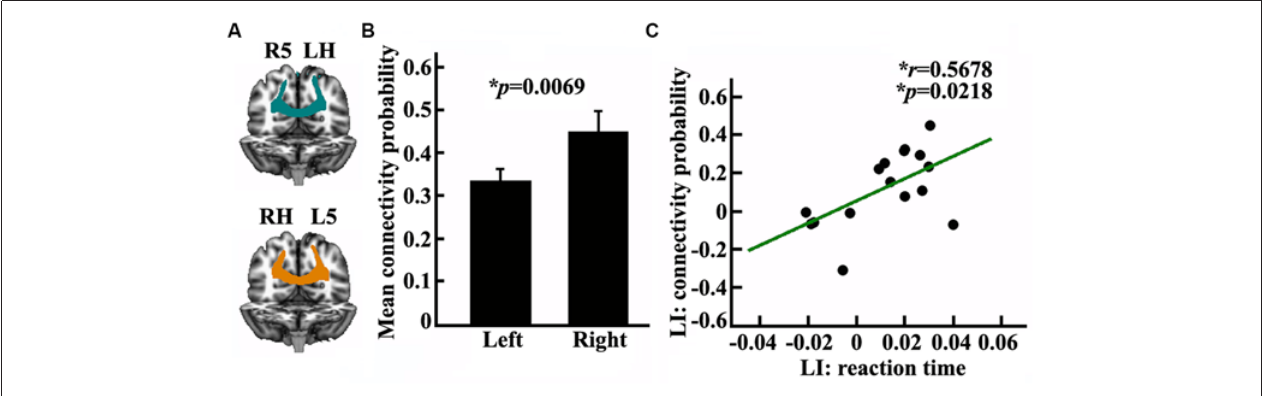
FIGURE 4 | Anatomical connectivity analyses between the posterior SPL and the contralateral posterior parietal cortex (PPC). (A) The white matter pathway of corpus callosum (CC) between the posterior SPL and the contralateral PPC is shown in the left panel, LH: left hemisphere, RH: right hemisphere, L5: the left posterior SPL subregion labeled #5, R5: the right posterior SPL subregion labeled #5. (B) The middle panel shows the mean anatomical connectivity probability and the standard error for the left and right posterior SPL to the contralateral PPC. (C) The correlation analyses for the LI of anatomical connectivity probability and the LI of the reaction time. The unit of reaction time is second (s). *Represents the statistically significant differences; FDR corrected, p <